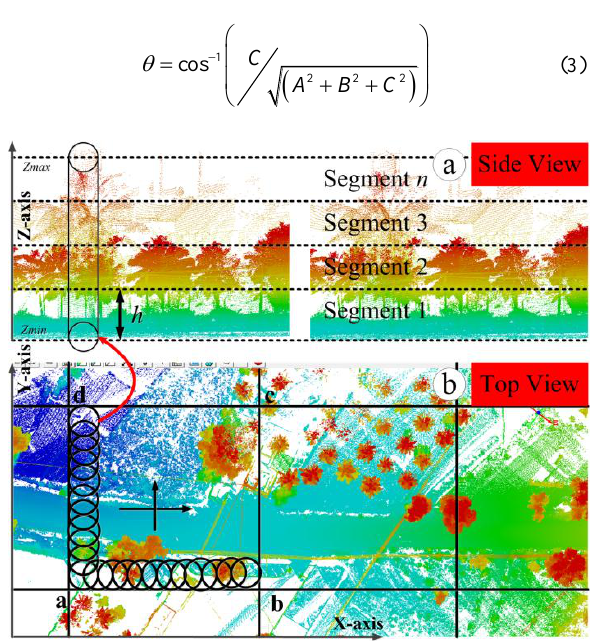
Figure 2. (a) Side view of MLS data points showing cylindrical region growing along Z-axis (b) Top view of data points showing circular region growing along X-axis and Y-axis All MLS data points within the cylindrical cluster may belong